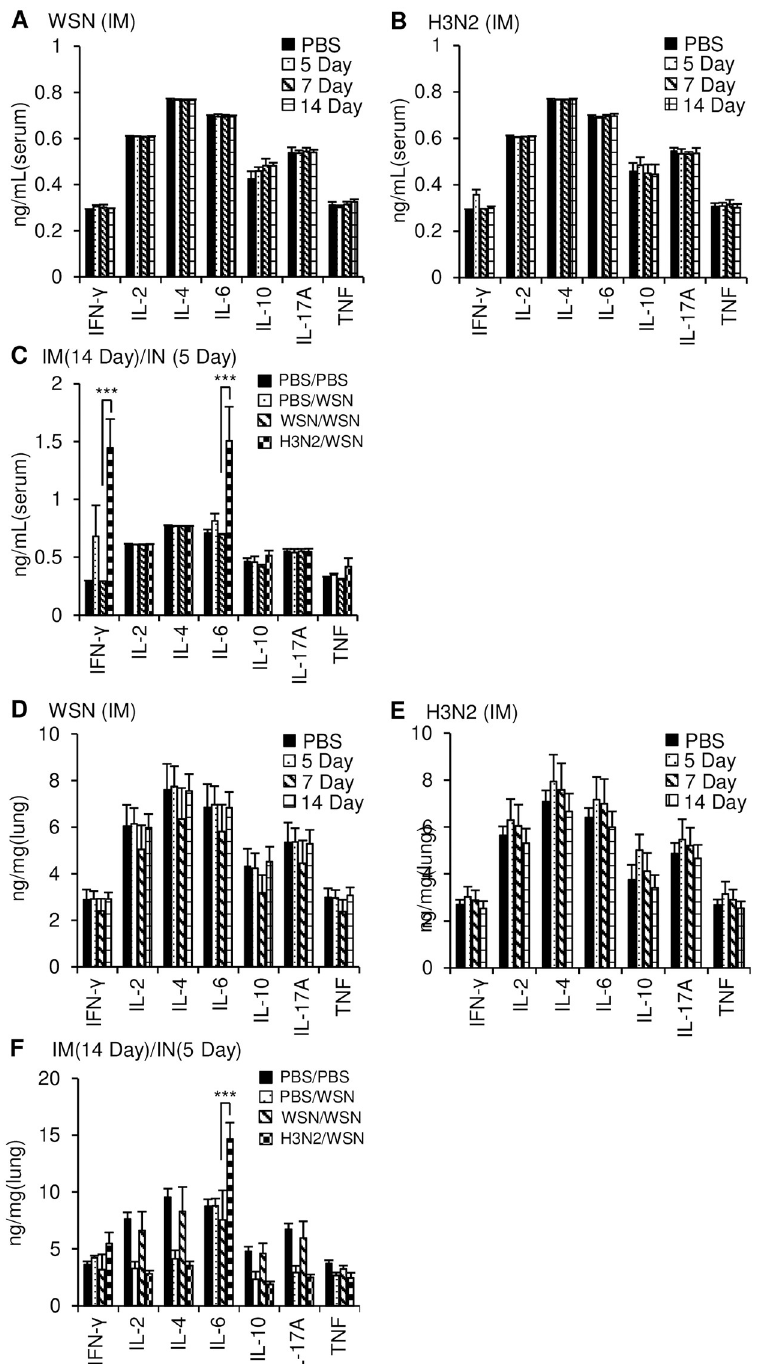
Fig 6. Cytokine levels in the sera and lung homogenates after intramuscular inoculation with live virus and/or intranasal virus challenge. BALB/c mice (n = 5) were intramuscularly injected with PBS, 5 × 10 6 pfu of live Influenza A/WSN/1933 (WSN) (A, D) or live Influenza A/Philippines/2/1982 (H3N2 Php) (B, E). Blood (A, B) and lungs (D, E) were collected after mice were sacrificed at the indicated time points after inoculation. Sera and lung homogenates were prepared, and levels of cytokines were quantified using a cytokine bead array. (C, F) BALB/c mice (n = 5) were intramuscularly inoculated with PBS, live WSN or live H3N2 Php. After 14 days, the mice were challenged intranasally with PBS or 10 LD 50 of WSN. Sera (C) and lung homogenates (F) were prepared at day 5 after the challenge, and levels of cytokines were measured by cytokine bead array. ��� p < 0.001.